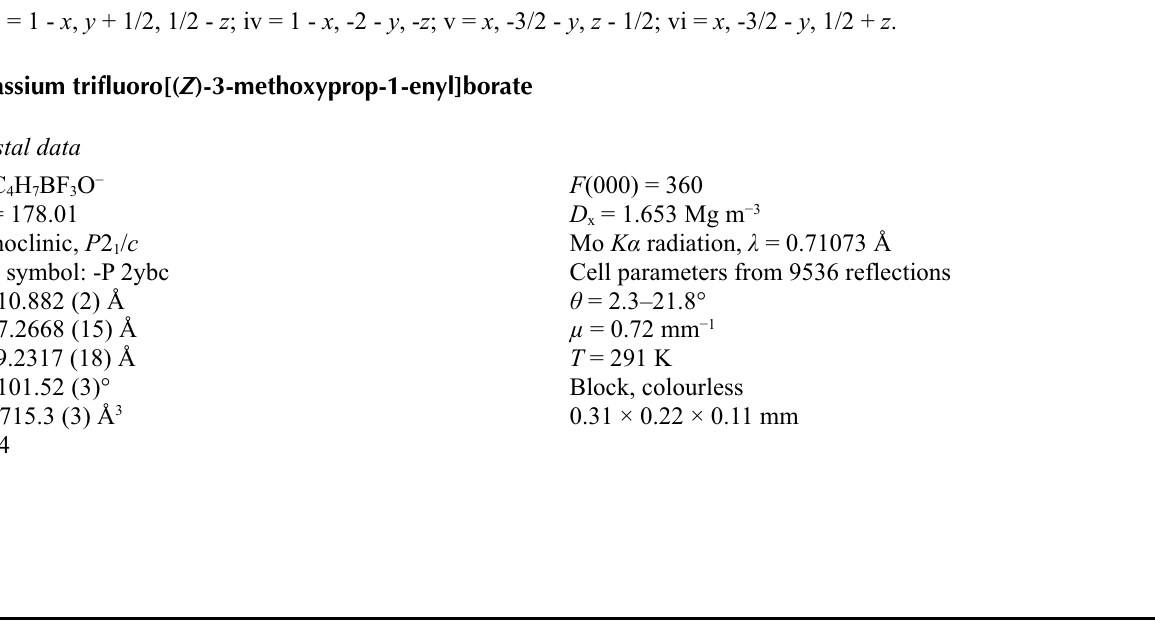
The trivacant icosahedron, fac -vIC-9, around the K + ion. Symmetry operations: i = 1 - x , y - 1/2, 1/2 - z ; ii = 1 - x , y - 1, - z ; iii = 1 - x , y + 1/2, 1/2 - z ; iv = 1 - x , -2 - y , - z ; v = x , -3/2 - y , z - 1/2; vi = x , -3/2 - y , 1/2 + z